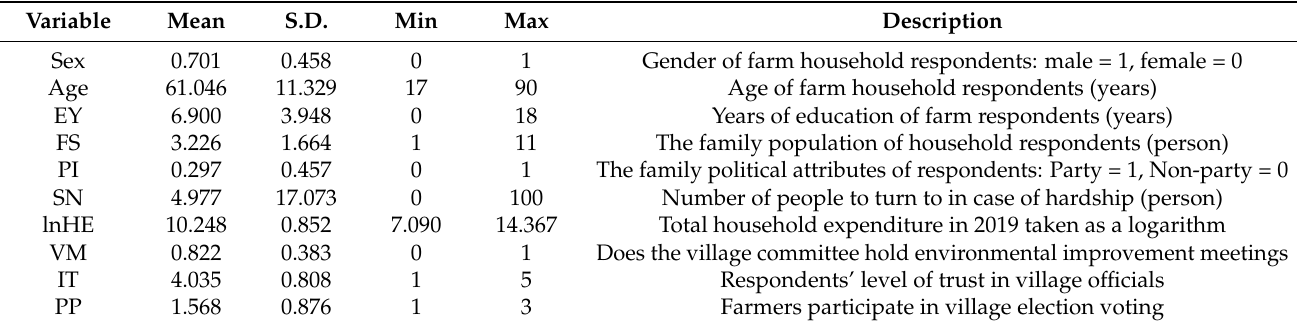
Table 4. Variable definition and descriptive statistics.